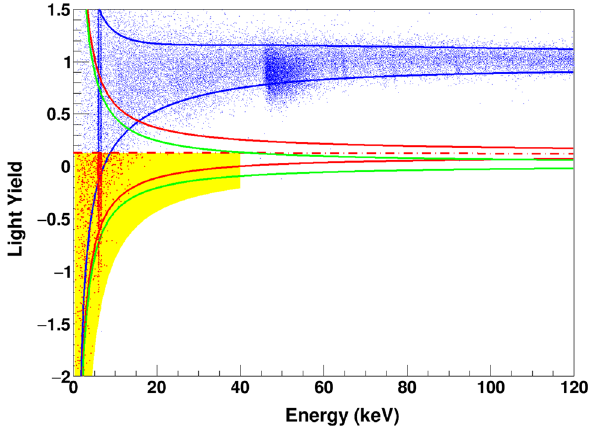
Fig. 1 All events from the detector module Lise after all cuts. The light yield, the fraction of light to phonon signal, is plotted against the (phonon) energy. Solid lines are 90% boundaries for electron recoils (blue) and nuclear recoils off oxygen (red) and tungsten (green). The red dashed line is the center of the oxygen band. The yellow area is the acceptance region